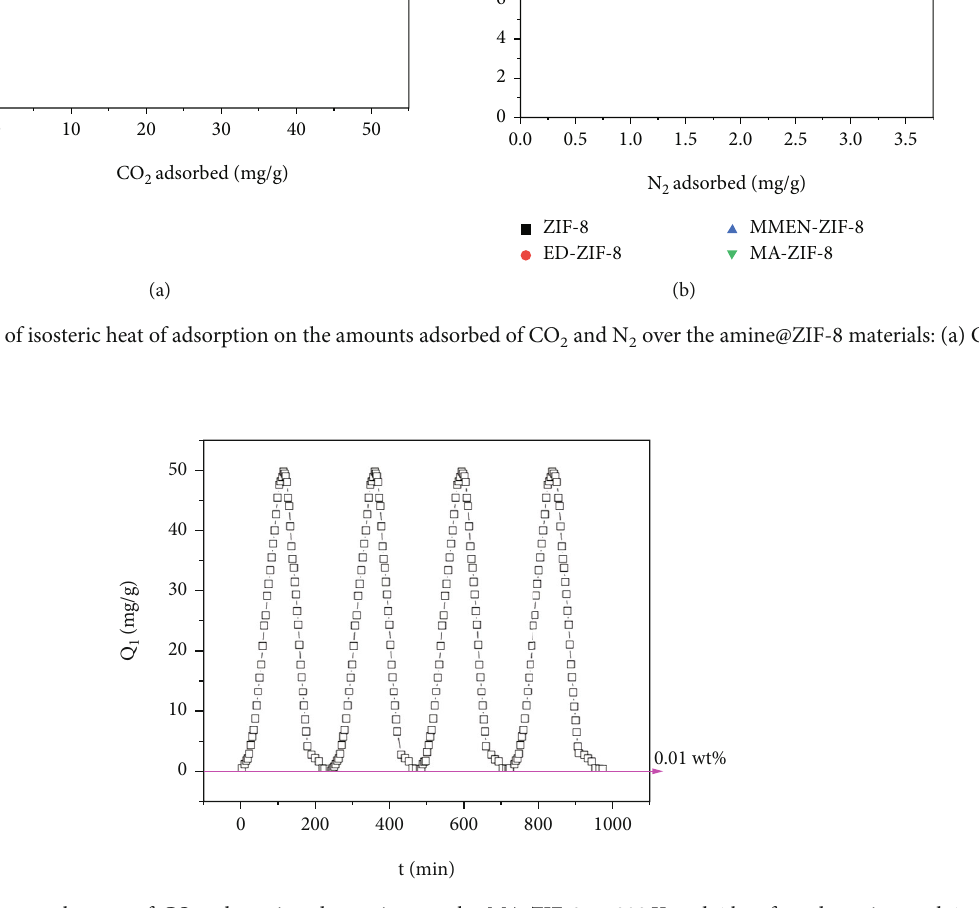
adsorption-desorption on the MA-ZIF-8 at 298 K and 1bar for adsorption and 1mbar for 2